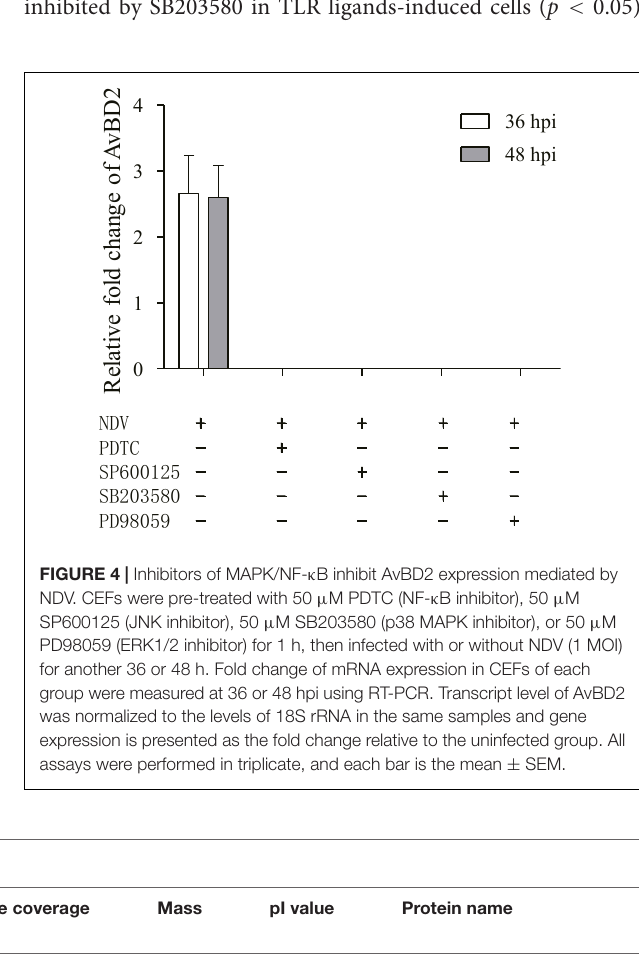
TABLE 1 | Analyses of AvBD2 by mass